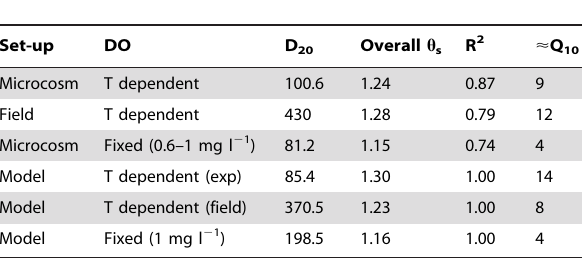
Model results using parameters fitted on the microcosm experiment with temperature dependent oxygen levels. Q 10 Estimates indicate the reaction rate increase at a 10 degree temperature rise.